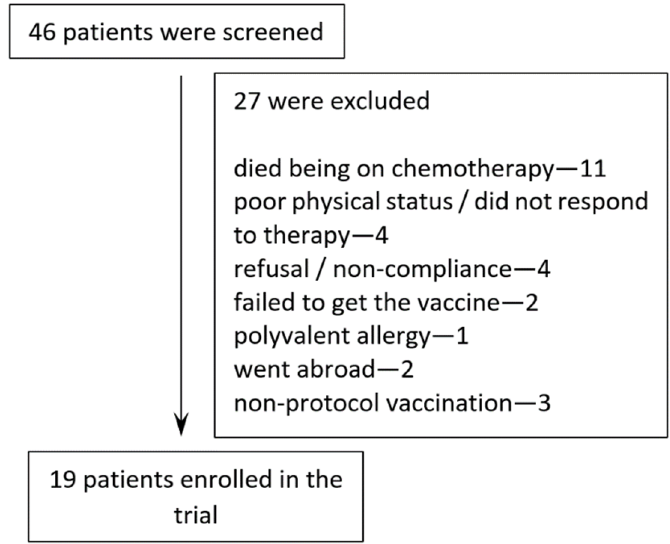
Figure 1. Patient cohort included in the study.